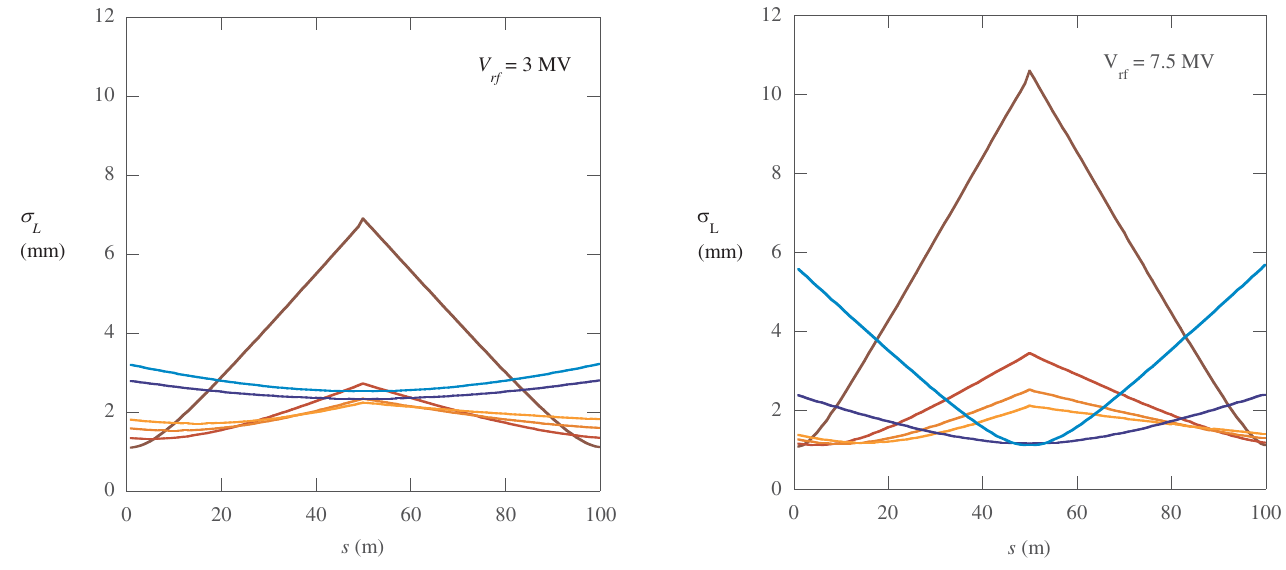
FIG. 10. (Color) Bunch length in mm along the ring for the example cited above. Blue lines, with the minimum at s (cid:6) 50 m , correspond to the monotonic case A and red to brown lines, with the maximum at s (cid:6) 50 m , to the nonmonotonic B. The cavity is placed at s (cid:6) 0